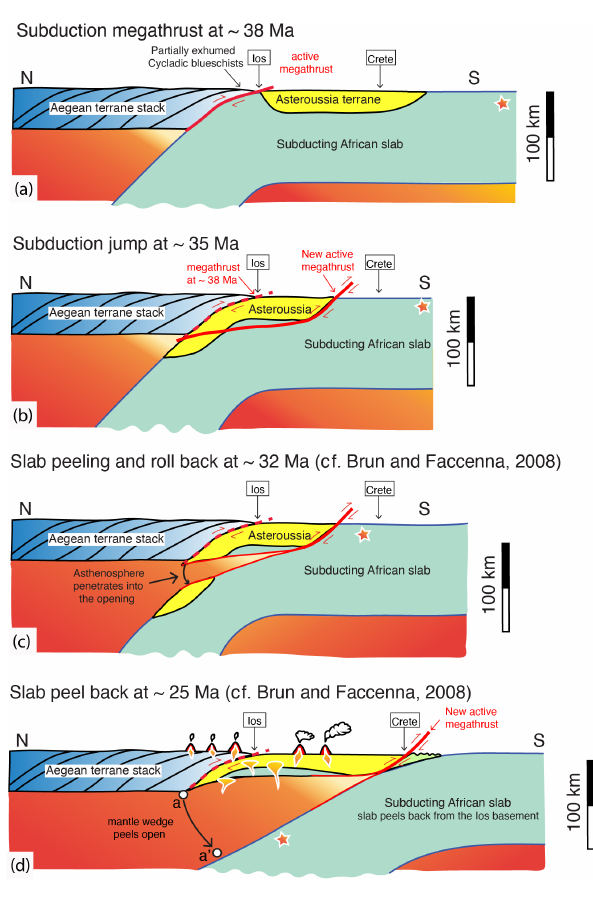
Figure 2. Schematic cross sections illustrating the slab-peel model. The orange star illustrates the relative movement of subducting ma- terial across time: (a) the Gondwanan Asteroussia terrane arrives at the subduction zone; (b) as it accretes to the terrane stack, the As- teroussia terrane underplates the youngest slice of the terrane stack; (c) the subduction megathrust jumps ∼ 300km southward, slicing the Asteroussia terrane from the subducting African slab, while sub- duction goes on and the slab continues to peel away from the “buoy- ant” Asteroussia terrane. Asthenosphere penetrates to the dilating megathrust (d) while the subducting African slab continues to roll back and the break widens. Melting of the uplifting asthenosphere causes extensive magmatism.